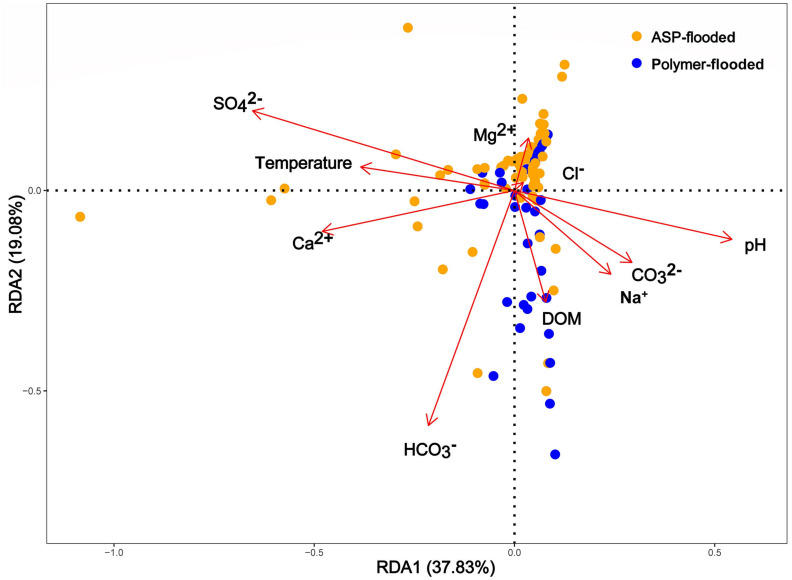
Spatially constrained, distance-based redundancy analysis of plot based quantitative bacterial community composition. The ASP-flooded and polymer-flooded samples (different color) are shown. Arrows indicate the direction of the maximum change in variables. DOM, Degree of mineralization (total salinity of water).